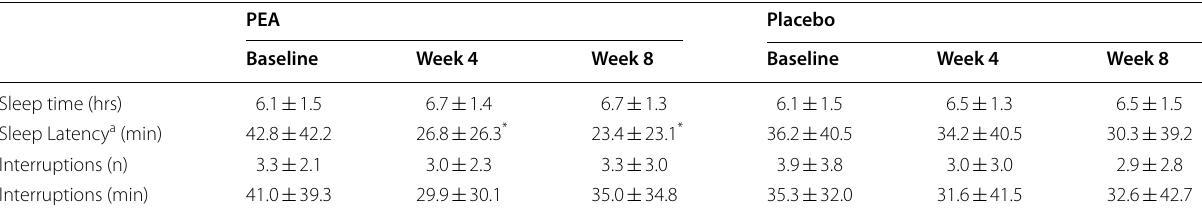
standard deviation; * significant difference between groups; a sleep latency data for participants reporting > 10 min at baseline ± =